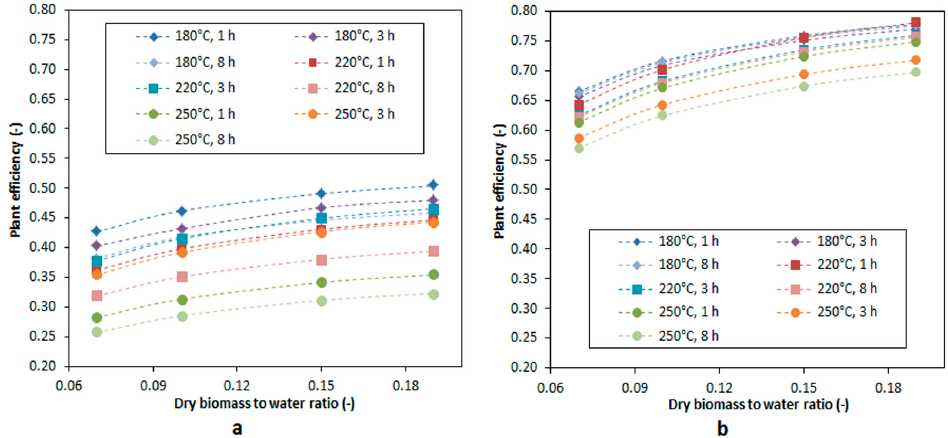
Figure 6. Plant efficiency at different HTC temperatures (180, 220, 250 °C) and residence times (1, 3, 8 h) vs. DB/W: ( a ) OSC; ( b ) GM. Indicators represent the simulation outputs, the curves connecting the indicators are intended to help the readers interpret the figure.